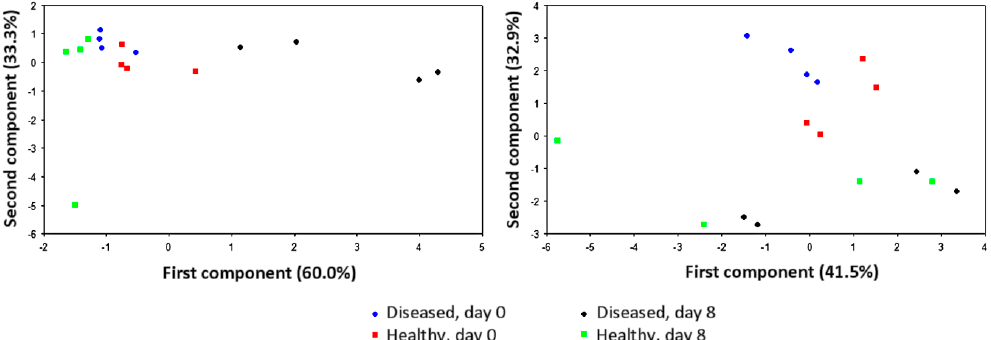
Figure 5. Score plots on the plane defined by the first two principal components of volatile compounds obtained by sensorial analysis of in vitro apple explants infected with E. amylovora , 0 and 8 days after inoculation. The two panels refer to analysis with EOS507C (left, with negligible drift of healthy samples) and with PEN3 (right, presenting a time-based drift).